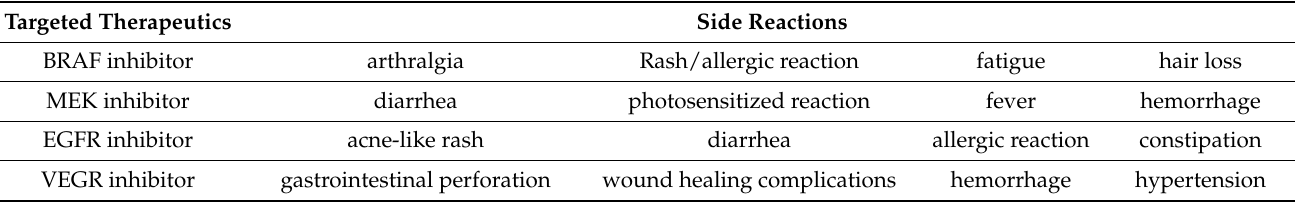
Table 2. Toxicities of Targeted